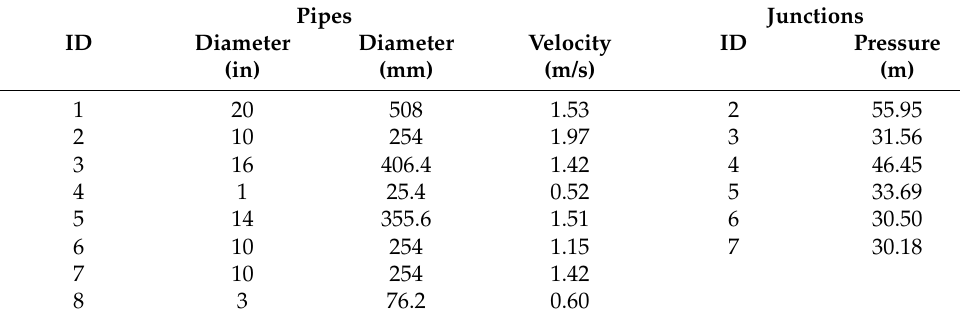
Table 5. Best solution for the two-loop